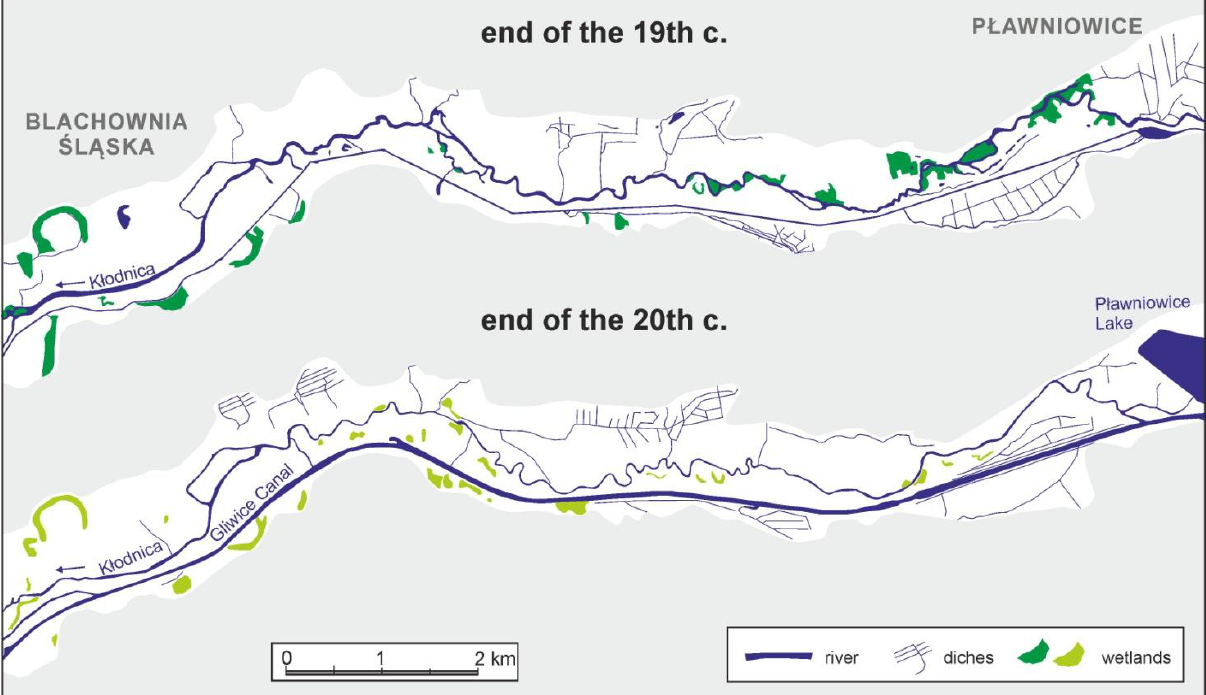
Fig. 5. Changes in the wetland areas since the end of the 19 th